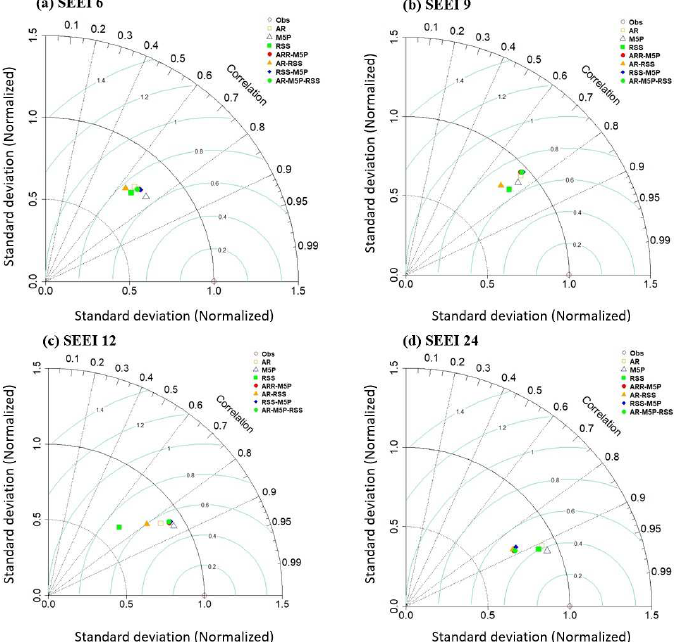
Figure 4. Taylor diagram representation of model ’ s performance in predicting SPEIs at Rajshahi station over multiple time scales during the testing period ( a ) SEEI-6; ( b ) SEEI-9; ( c ) SEEI-12; ( d ) SEEI-24.